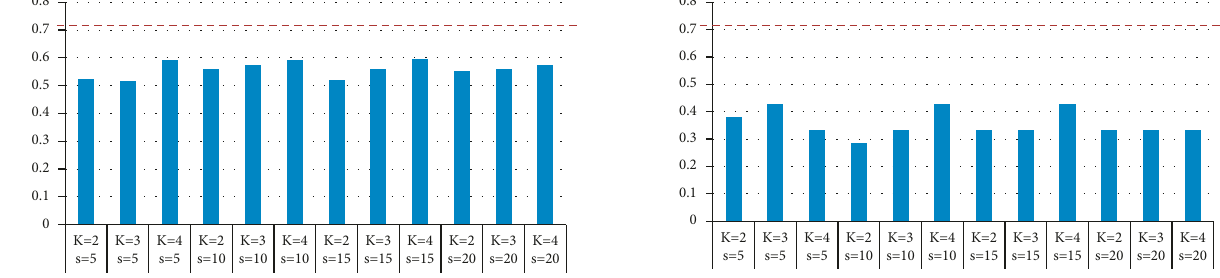
Figure 4: G -mean of CBCD on GS with a threshold 0.01.